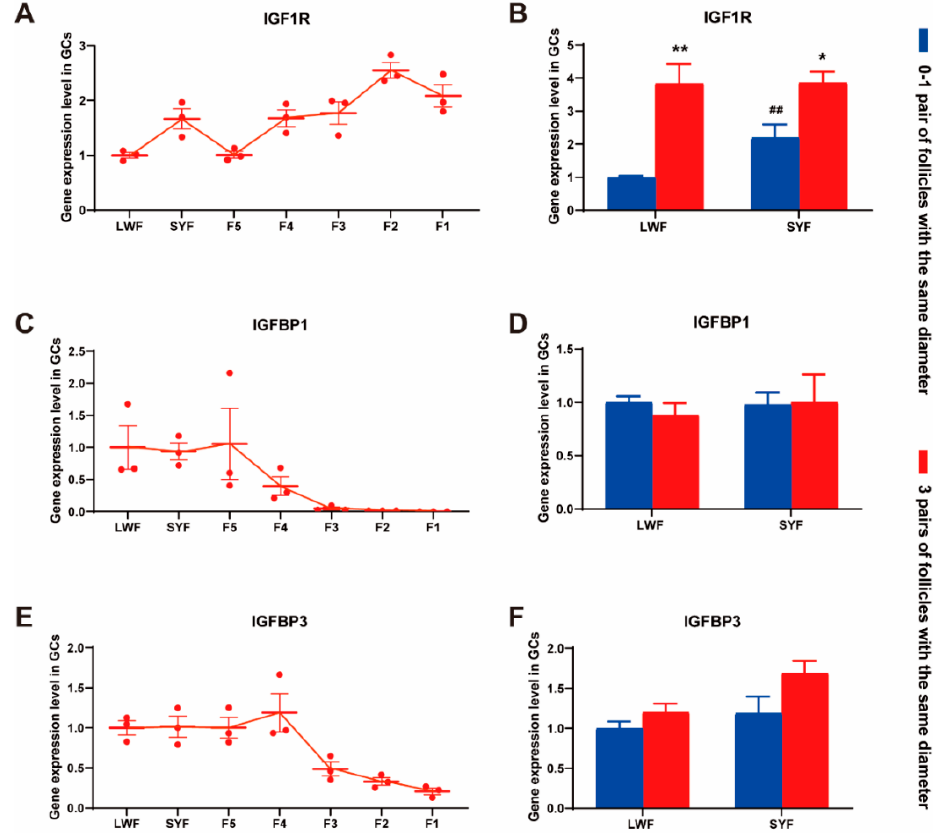
Figure 5. IGF1-related gene expression in granulosa cells. ( A , C , E ) IGF1R , IGFBP1 and IGFBP3 expression in granulosa cells of different follicles. Data are expressed as mean ± SEM (n = 3). ( B , D , F ) IGF1R , IGFBP1 and IGFBP3 expression in granulosa cells of small follicles divided into two groups (0–1 pair group and 3 pairs group). Data are expressed as mean ± SEM. * p < 0.05 and ** p < 0.01, compared to 0–1 pair group; ## p < 0.01, compared to LWF group.